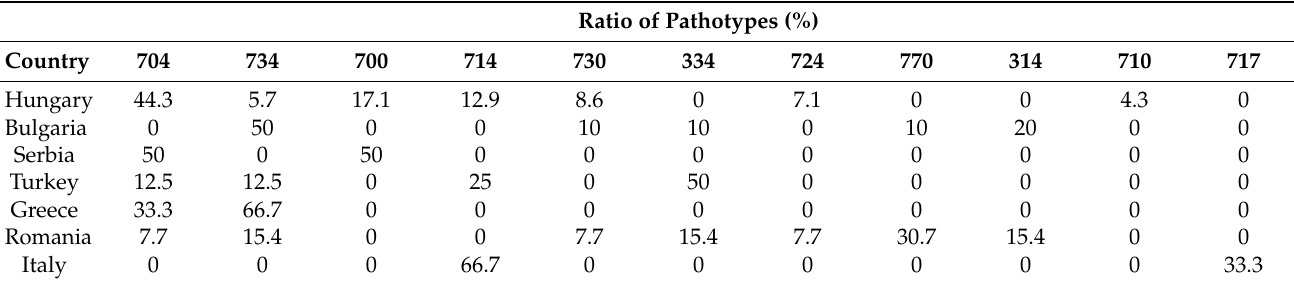
Table 4. Distribution of Plasmopara halstedii pathotypes by countries in Europe (2012–2019). Ratio of Pathotypes